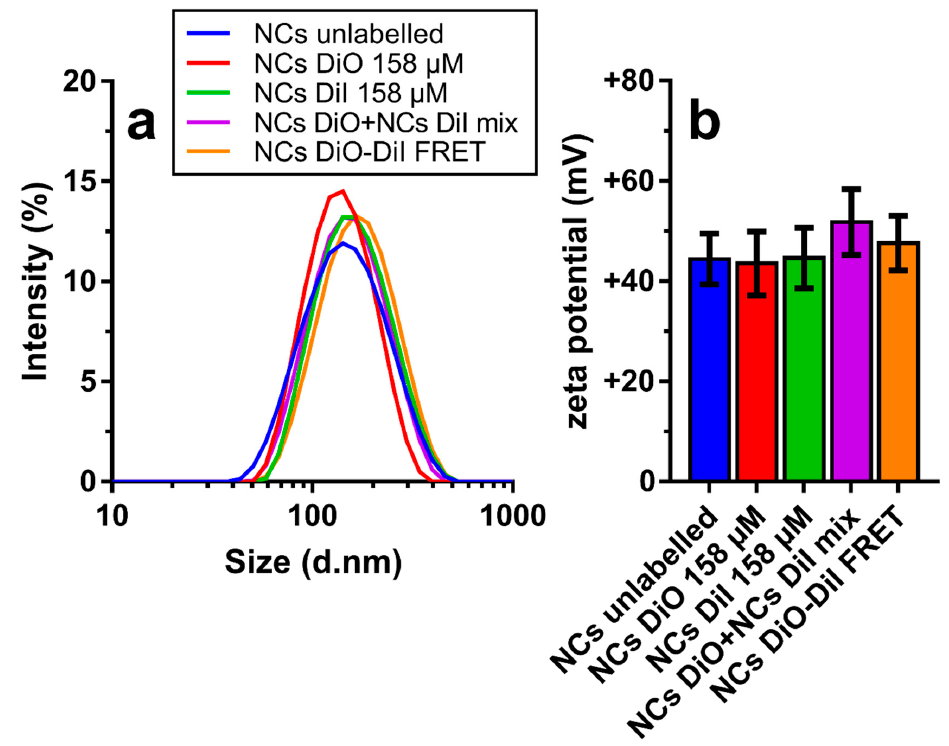
Figure 1. Physicochemical characterization of loaded and unloaded nanocapsules (NCs) by DLS-NIBS. ( a ) Scattering intensity over size; and ( b ) Zeta potential measured by diluting NC stocks 1:100 in water at 25 °C. Error bars in ( b ) represent standard deviation from 10 sub-runs used in the zeta potential measurements.